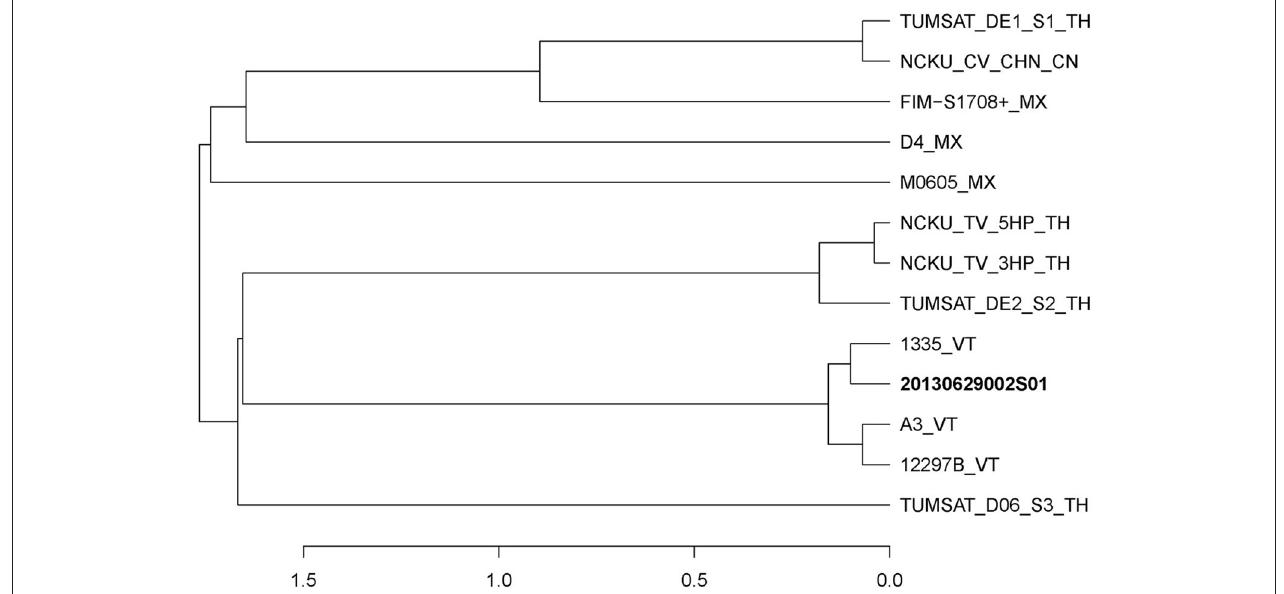
FIGURE 1 | Distance dendrogram among Vibrio parahaemolyticus strains based on ANI values. The ANI values were calculated using 13 strains, and all values between every two strains were greater than 98%. The complete genome sequences of V. parahaemolyticus (M0605, D4, FIM-S1708 + , NCKU_CV_CHN,